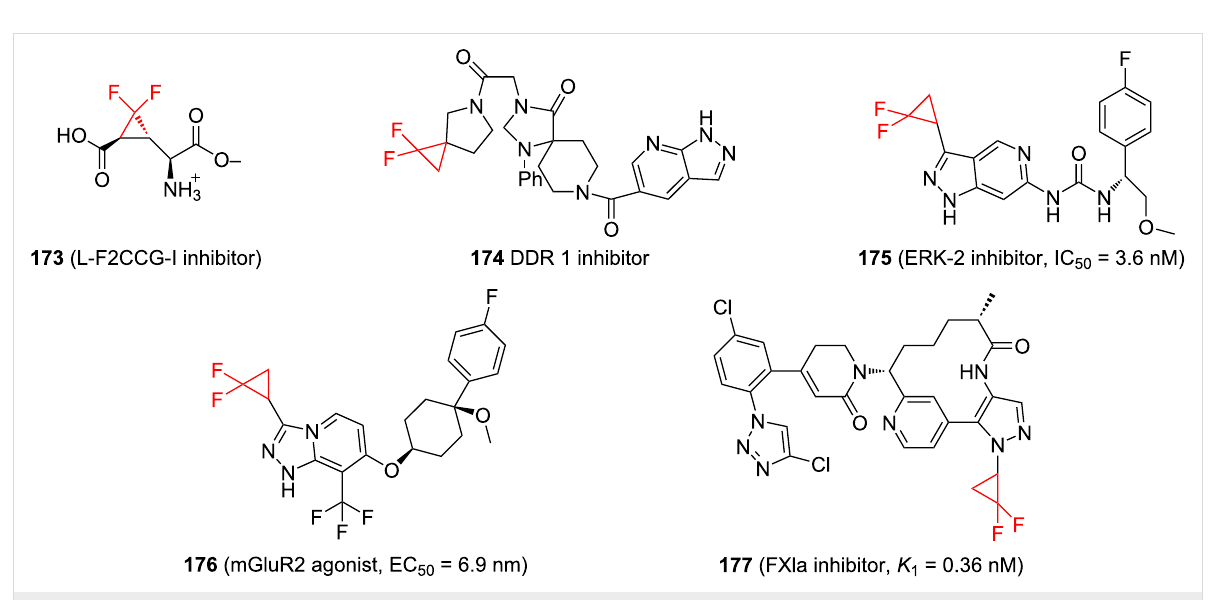
Figure 3: Further examples of difluorcyclopropanes in modern drug discovery.